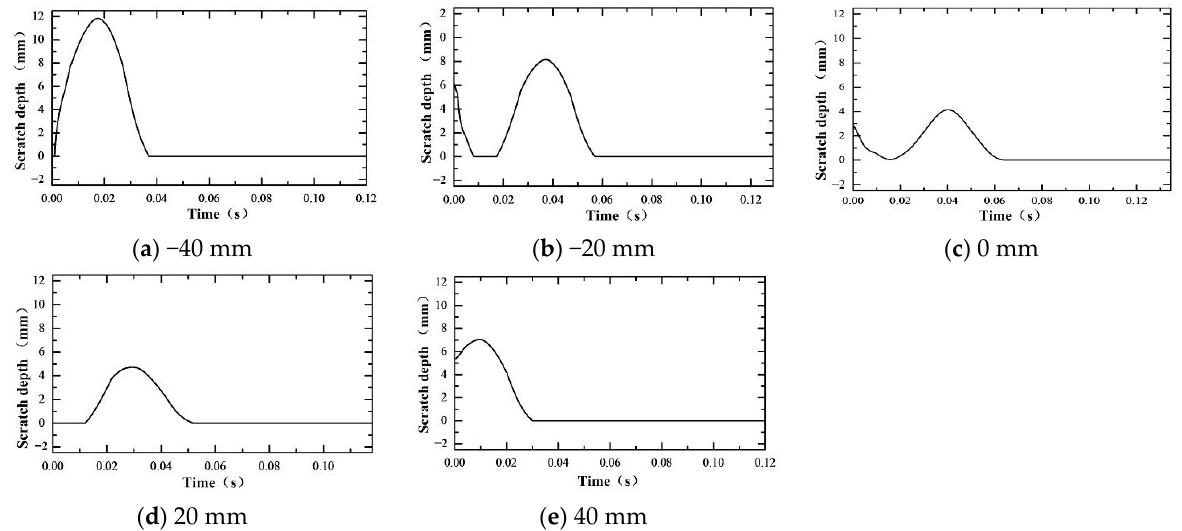
Figure 29. Scratch damage depth with different magnetic field eccentricities.